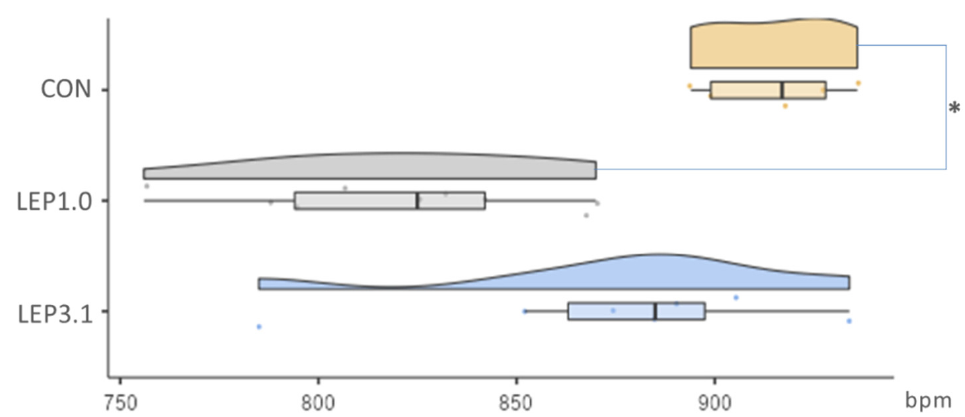
Figure 6. Mean heart rate (beats/min) during episodes of reperfusion-induced ventricular tachycardia. CON, control; LEP1.0, leptin 1.0 nM; LEP3.1, leptin 3.1 nM. Data are presented as mean ± standard deviation. * p < 0.001.